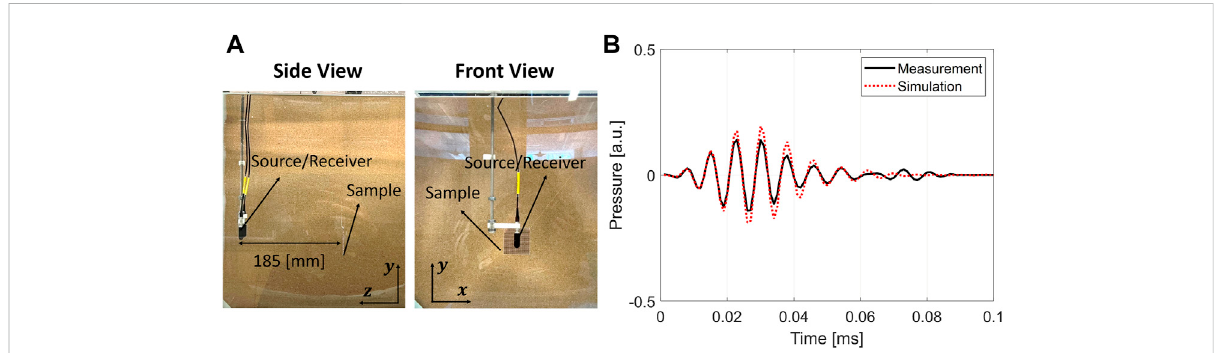
Measurement setup (A) and simulated echo using the predicted material parameters (B) . The far- fi eld echo simulated using the predicted materialparametersshowsexcellentmatchwiththemeasurement,anddemonstratesthattheCNNestimateswelltheeffectivematerialparameters of the